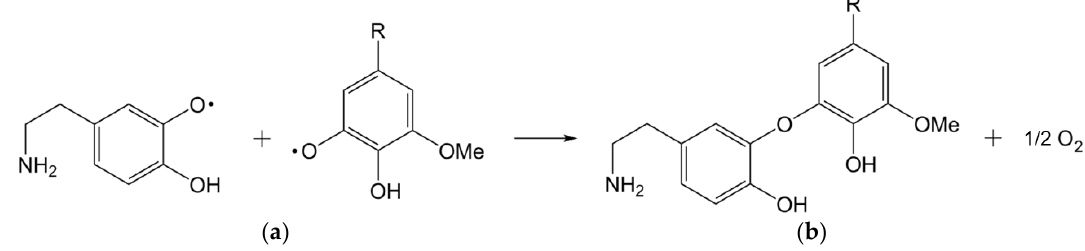
Figure 4. Bonding of ( a ) dopamine to ( b ) lignin via radical coupling.